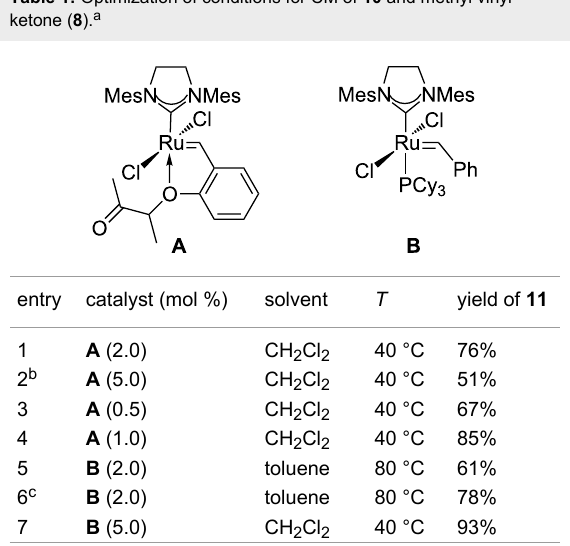
entry catalyst (mol